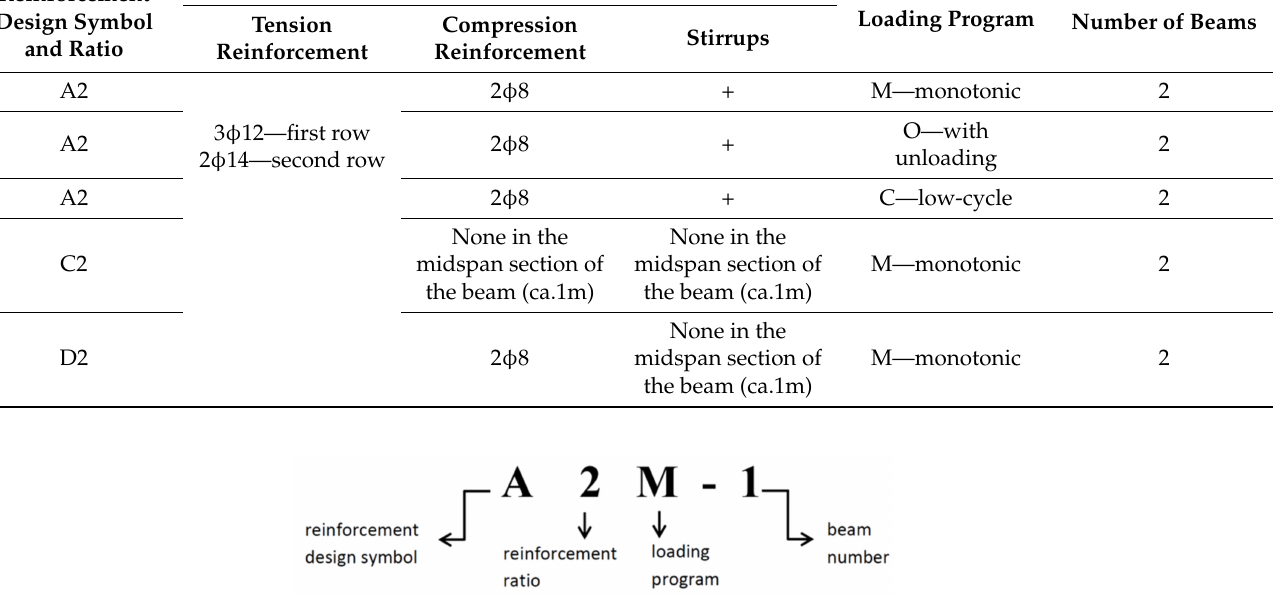
Figure 1. Beam designation